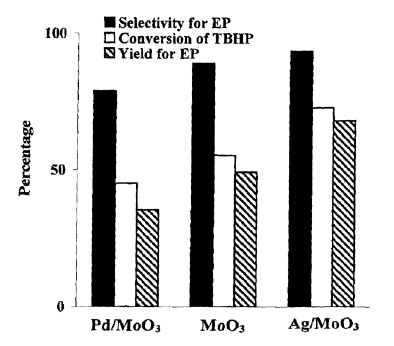
, Pd/MoO and MoO 3 3 3